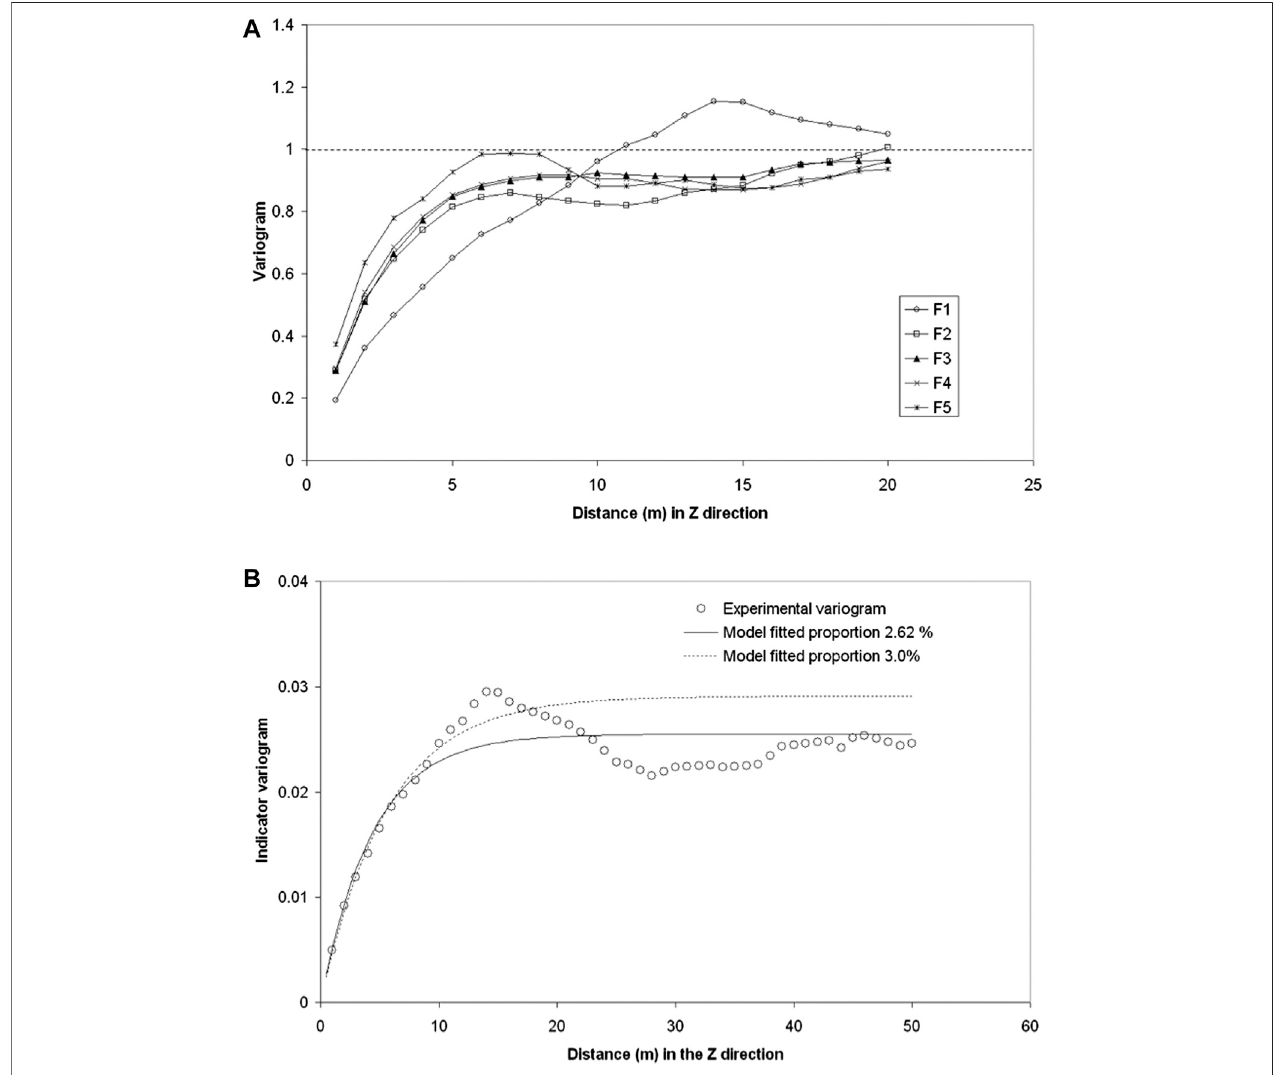
FIGURE 3 | (A) Standardized indicator variograms calculated along the boreholes for the fi ve hydrofacies and standardized by their variances. (B) Indicator variogramoffaciesF1alongtheborehole and thetwobestmodels fi ttedwhichwerethose forhydro faciesF1 proportions of2.62and 3.00% whichimpliesvariancesof 0.0255 and 0.0291, respectively, and fi tted ranges of 4.37 and 5.62 m, respectively, for an exponential variogram model.